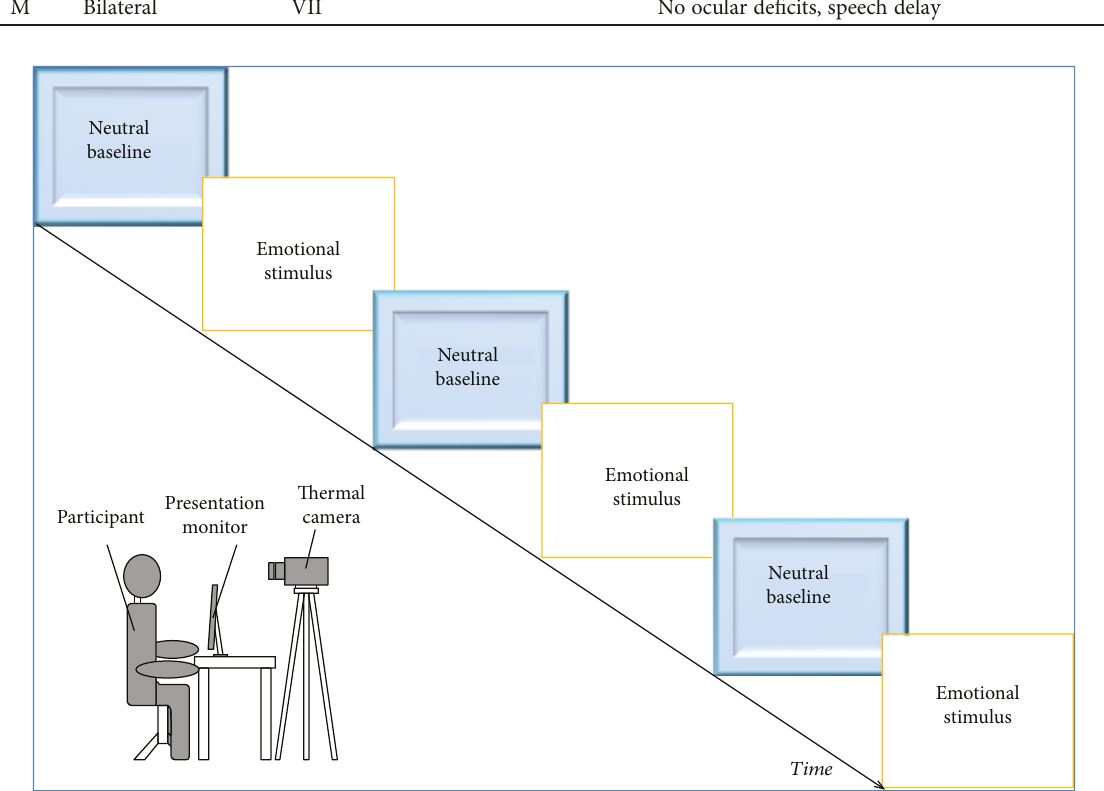
Figure 1: Experimental paradigm. Schematic overview of the experimental